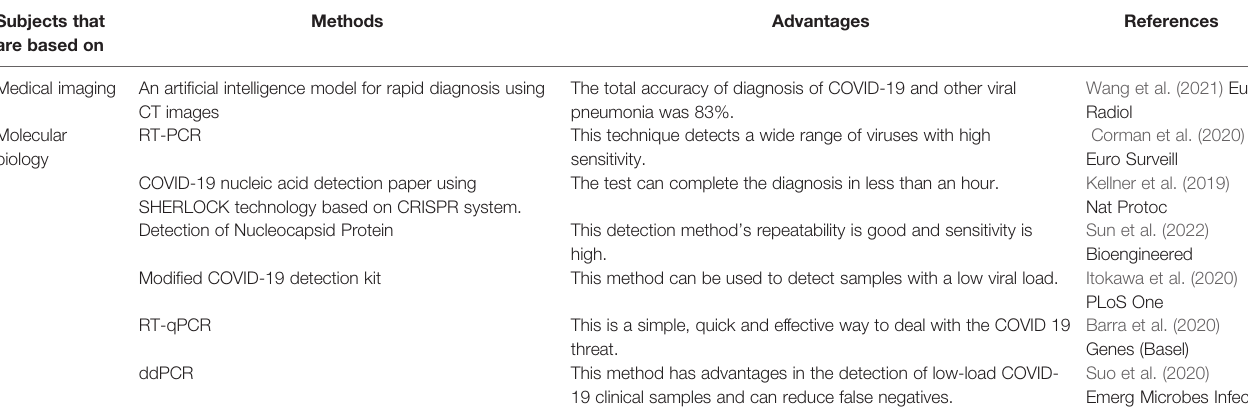
TABLE 1 | The diagnosis and detection of SARS-CoV-2 and